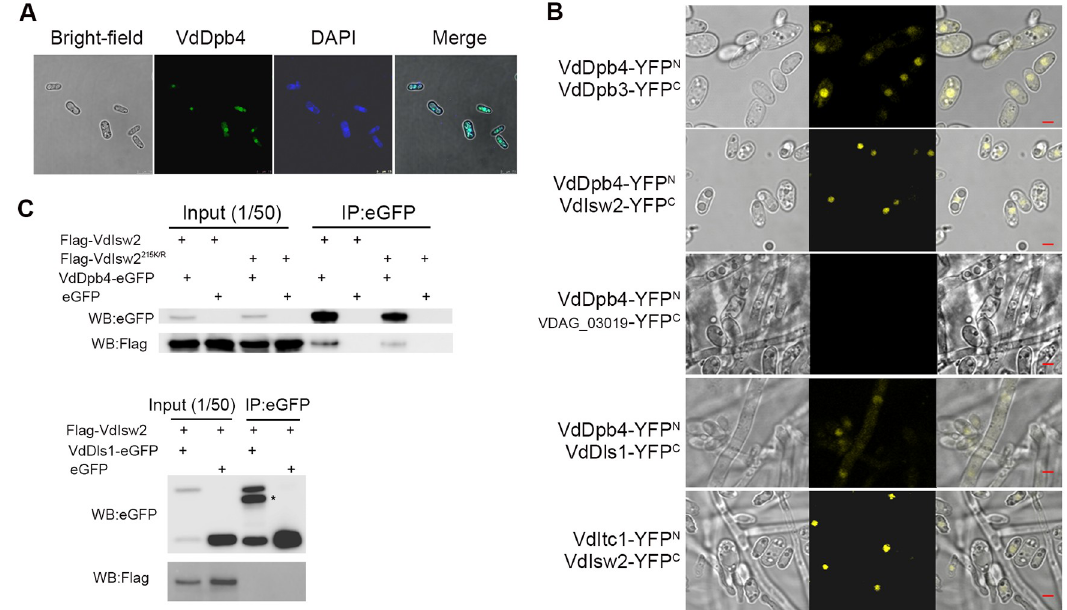
Fig 4. Identification of VdDpb4-associated proteins in vivo. A. Visualization of the location of VdDpb4 labeled with eGFP; conidia were stained with DAPI and then observed by fluorescence microscopy. Bar = 7.5 μ m. B. BIFC assay showing the interaction of VdDpb4 and VdDpb3, and VdIsw2, and the interaction of VdIts1 and VdIsw2. All constructs were transformed into V592, and the signal was detected by fluorescence microscopy. VDAG_03019, a nuclear transcription factor Y subunit B-3 protein, was cotransformed with VdDpb4 as the negative control. Bar = 2.5 μ m. C. Immunoblot of the coimmunoprecipitation. Vd Δ dpb4 expressing VdDpb4-eGFP and 3xFlag-VdIsw2, or Flag-VdIsw2 215K/R or eGFP, and V592 expressing Flag-VdIsw2 and VdDls1-eGFP, respectively, was cultured on MM medium for 3 days, and the conidia were collected for the Co-IP assay. � :a degraded protein or isoform.